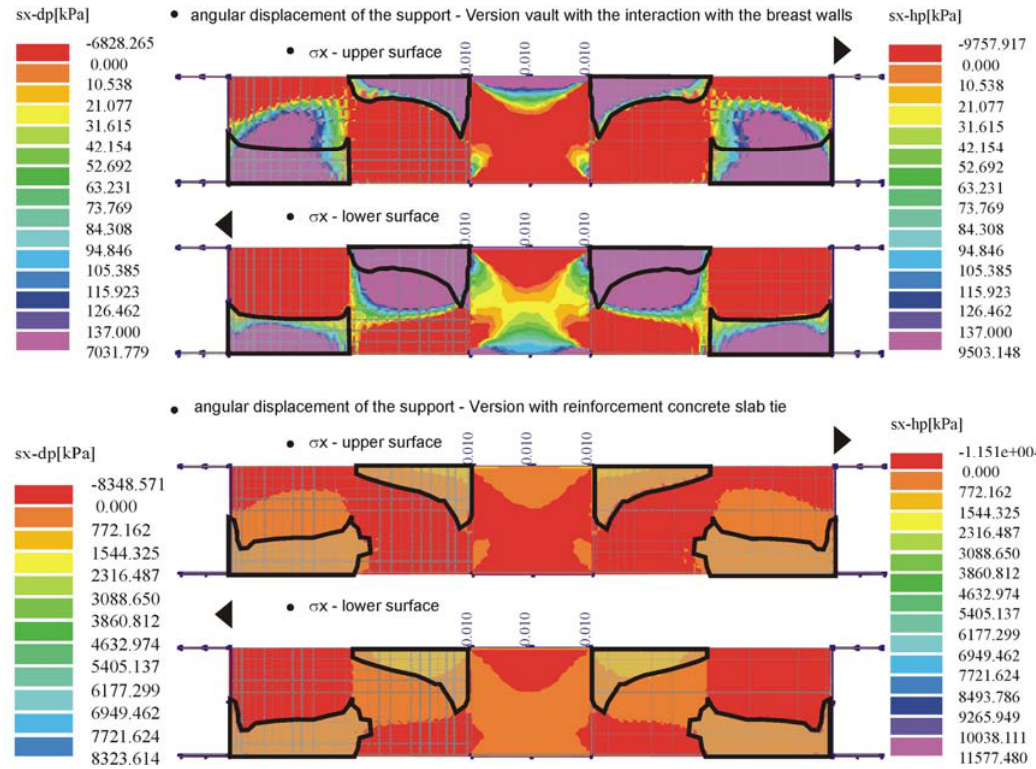
Fig 9. Areas of tensile normal stress + σ x occurrence acting along whole vault cross-section (areas of tensile stresses acting along whole cross-section highlighted in bold) first iteration – response of